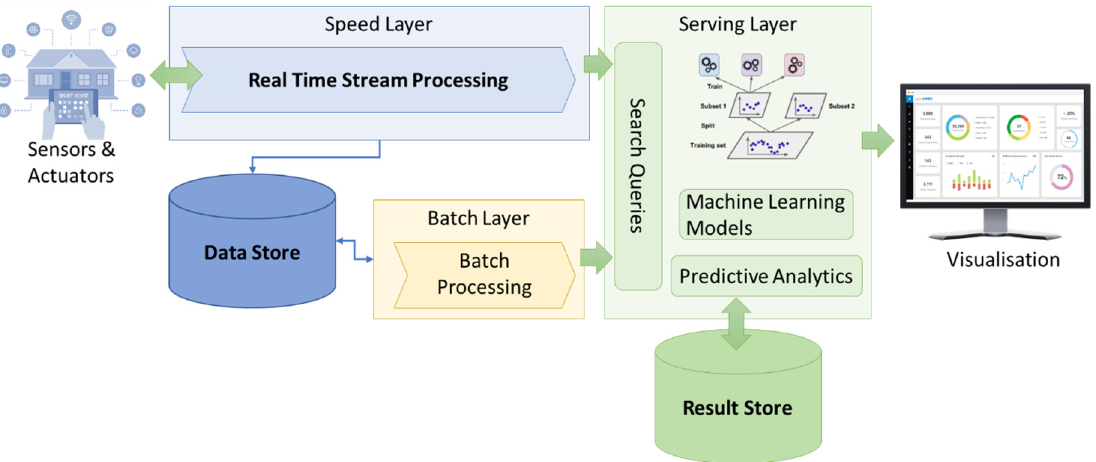
Figure 3. High level physical big data architecture.